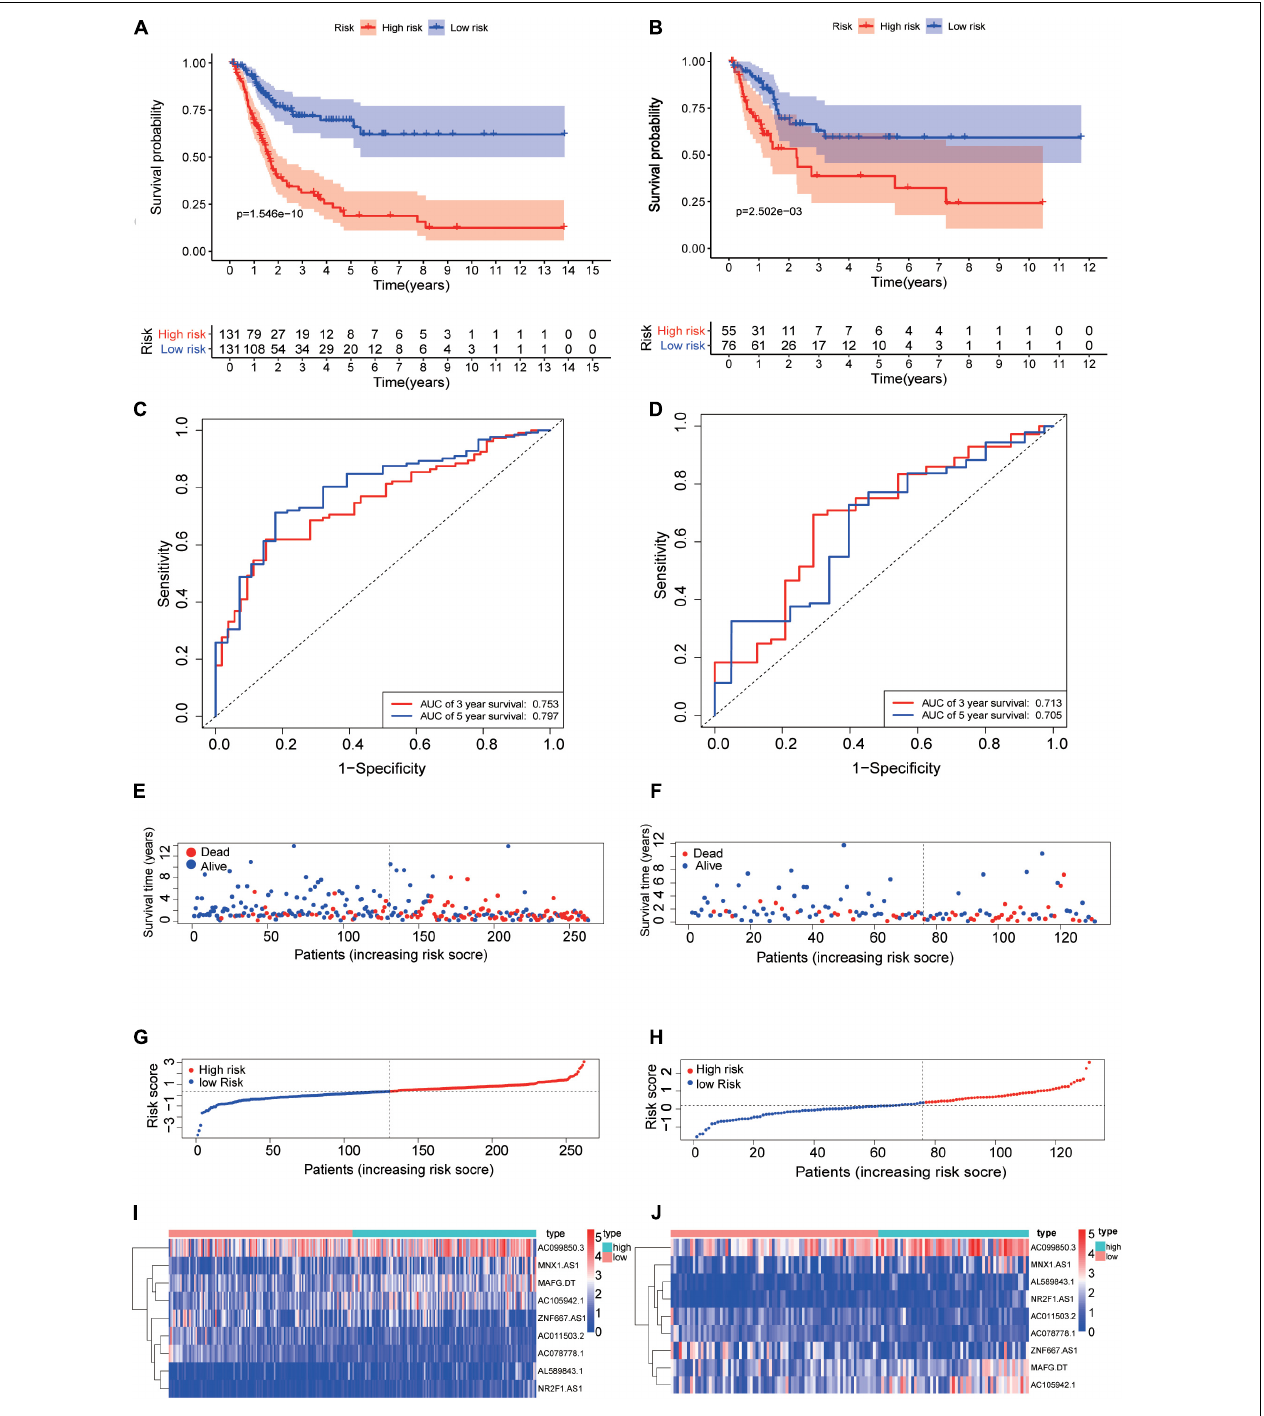
FIGURE 4 | Construction of risk score model. Kaplan-Meier survival analysis showed that the Overall Survival (OS) of patients in the high-risk training set (A) and validation set (B) was significantly lower than that in the low-risk group. The ROC curve of the training set (C) showed that the AUCs of the 3-year and 5-year OS were 0.753 and 0.797, respectively, while the validation set (D) were 0.713 and 0.705, respectively. Survival rate and survival status of bladder cancer patients in the training set (E) and validation set (F) . The distribution of 9 glycolysis-related lncRNAs risk scores for each patient in the training set (G) and validation set (H) . Heatmap of 9 glycolysis-related lncRNAs in the low-risk group and the high-risk group in the training set (I) and validation set (J) .